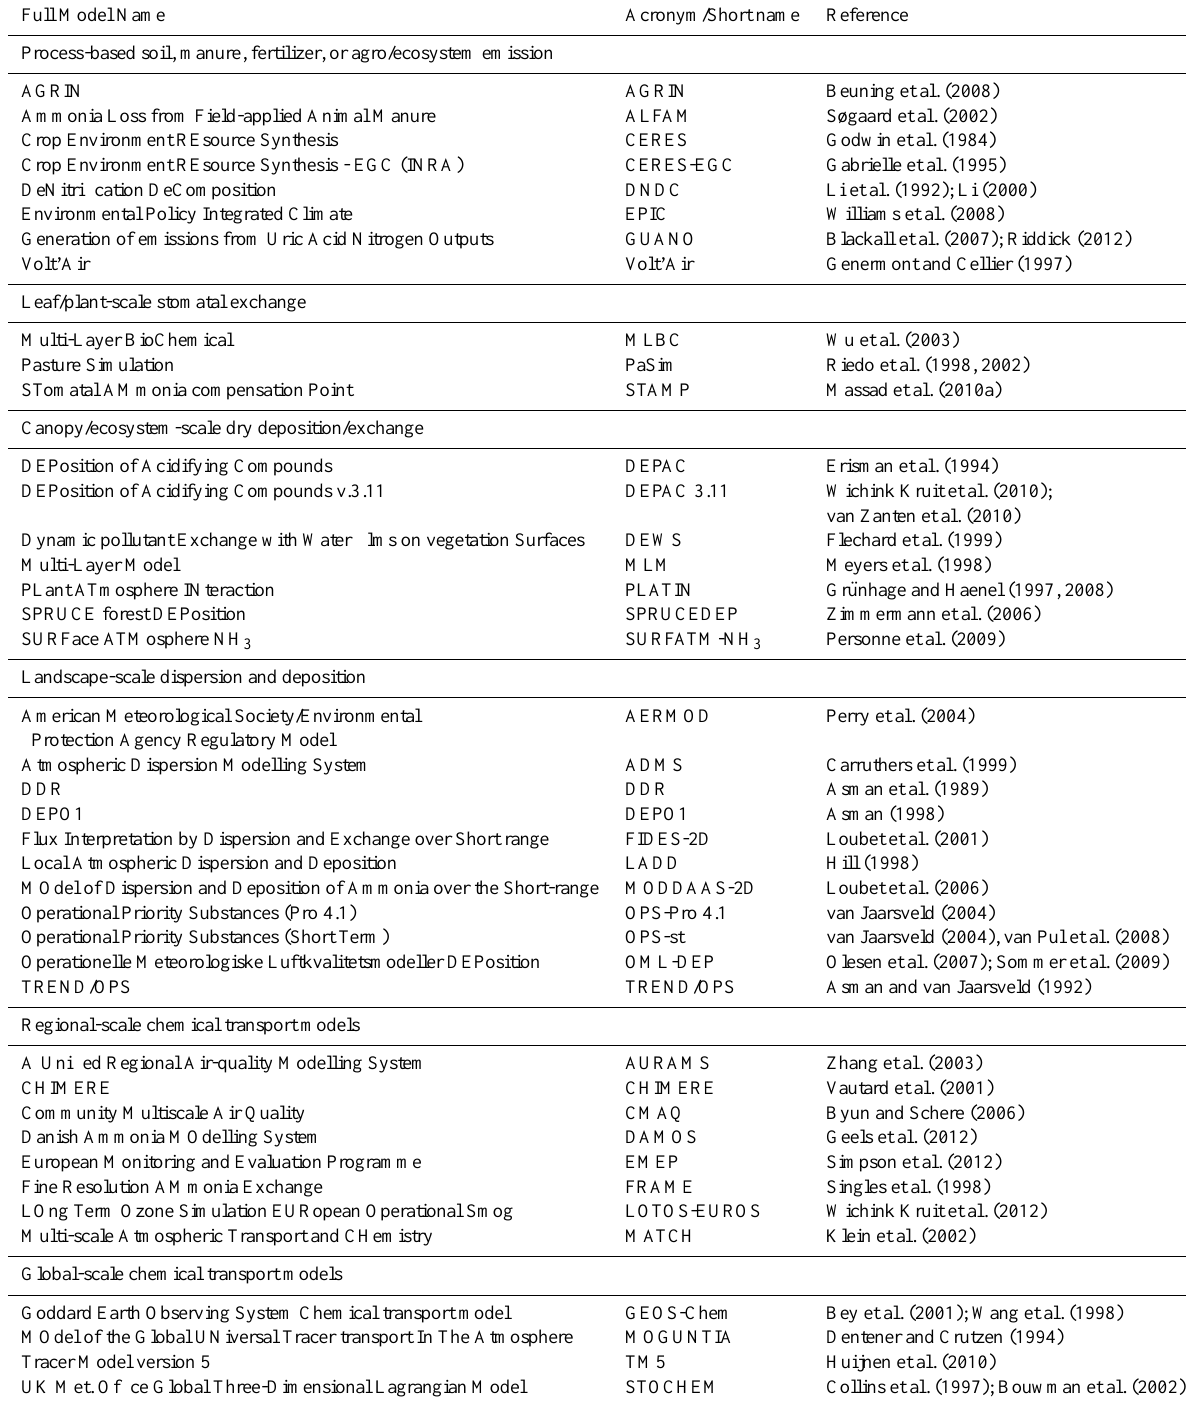
Table 1. A selection of soil, plant, ecosystem, atmosphere models, dealing with NH 3 emission, dry deposition, bi-directional exchange, dispersion, chemistry, transport, from the process scale to the global